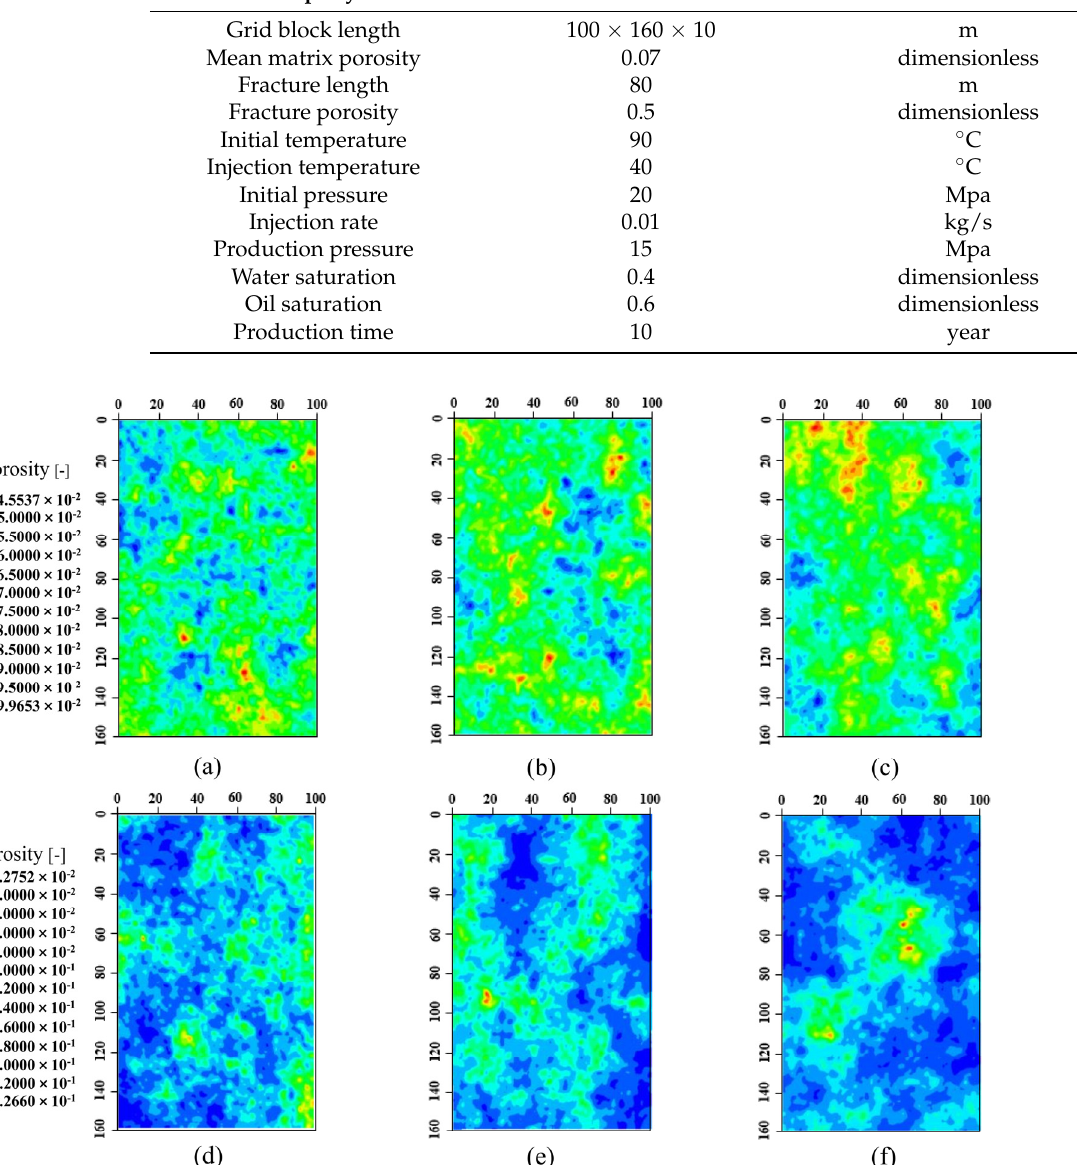
Figure 4. Generated porosity distribution field. ( a ) SD = 0.025 (-), CL = 12.5 m; ( b ) SD = 0.025 (-), CL = 25 m; ( c ) SD = 0.025 (-), CL = 50 m; ( d ) SD = 0.05 (-), CL = 12.5 m; ( e ) SD = 0.05 (-), CL = 25 m; ( f ) SD = 0.05 (-), CL = 50 m; ( g ) SD = 0.1 (-), CL = 12.5 m; ( h ) SD = 0.1 (-), CL = 25 m; ( i ) SD = 0.1 (-), CL = 50 m.